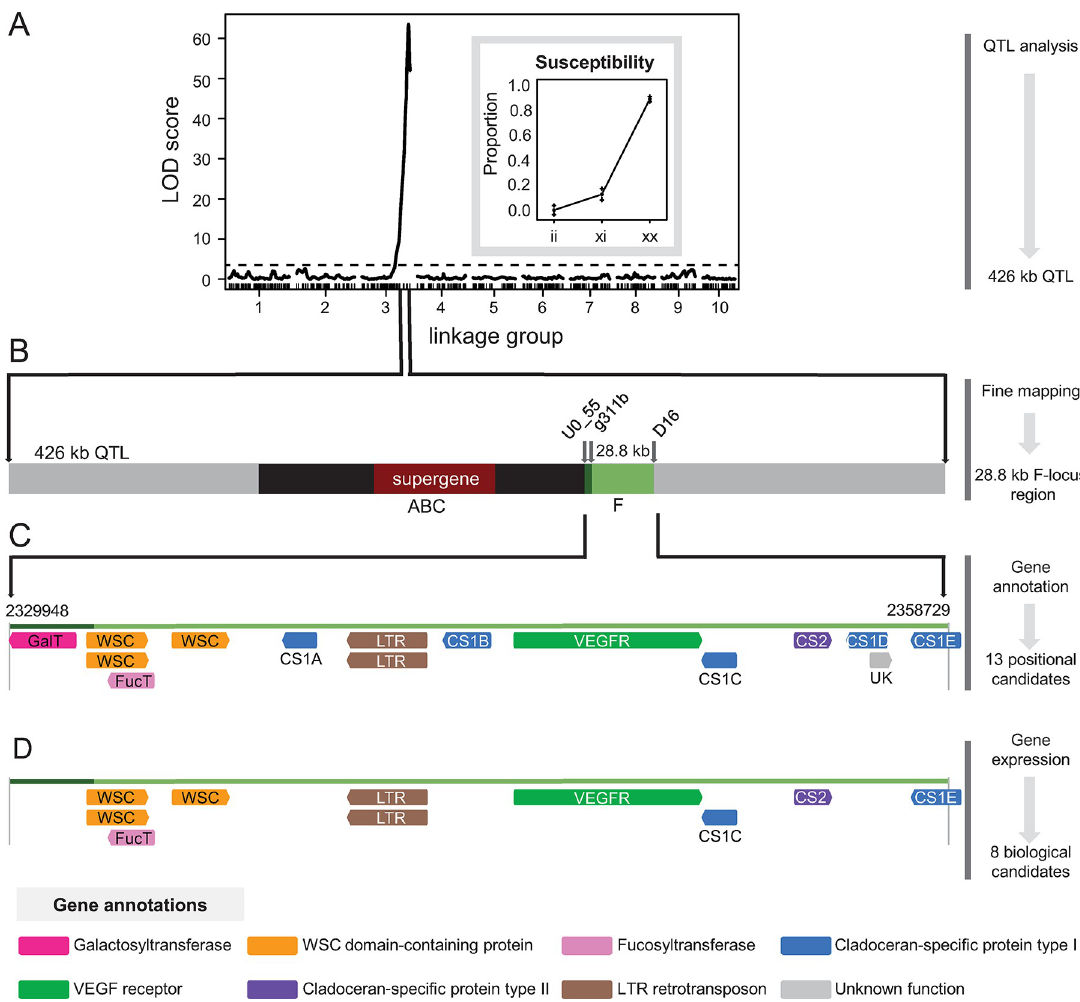
Fig 1. QTL mapping of the polymorphism in Daphnia magna resistance to Pasteuria ramosa genotype P21. Overview of the workflow used in this study to narrow in on candidate genes underlying a resistance polymorphism. Using QTL mapping and recombination breakpoint mapping with additional markers, we associated the polymorphism in resistance phenotype (attachment of Pasteuria ramosa genotype P21 to the hindgut of Daphnia magna hosts) to a 28.8-kb region at the end of linkage group 3 ( Daphnia magna genome version 2.4) which we call the F-locus region. A) Results of the single-QTL genome scan (i.e., interval mapping), showing LOD score (log 10 likelihood ratio) plotted at each SNP marker position in the D . magna genetic map. A strong peak with LOD score 63 explains 57% of the phenotypic variance in resistance to P21. The horizontal dashed line indicates the calculated threshold (LOD = 3.74) used to identify significant ( α = 0.05) QTL. Effect plot (inset) of the SNP marker with the highest LOD score, showing proportion of F2 clones in each genotype group (ii = homozygous for Iinb1 parent clone; xi = heterozygous; xx = homozygous for Xinb3 parent clone) that are susceptible to hindgut attachment by P21. Error bars indicate ± 1 standard error. B) Enlarged schematic view of the 426-kb QTL containing the resistance locus ( D . magna genome version 3.0). The fine-mapped location of the F locus, delimited by SNP markers U0_55 and D16, is shown in green. This F-locus region slightly overlaps with the previously described ABC region (black), which is delimited by SNP marker g311b. The ABC region includes the 50-kb ABC supergene (red), which contains the A, B, and C loci. C) Enlarged schematic of the F-locus region, which lies between positions 2,329,948 and 2,358,729 on contig 000011F and contains 13 putative genes (colored by functional annotation), plus two splice variants, in the reference genome (version 3.0) of clone Xinb3. The region colored in dark green indicates the overlap with the ABC region. D) Sequence comparisons and differential gene expression analysis between the two QTL parent clones identified eight biological candidate genes in the F-locus region. 2,329,948 and 2,358,729 of contig 000011F in the D . magna draft genome version 3.0 (from QTL parent clone Xinb3; BioProject ID: PRJNA624896; Fields et al., in prep.). We call this newly discovered interval the “F-locus region” (i.e., the region containing the F locus), follow- ing from the previously described loci A, B, C, D, and E [16–18]. The F-locus region contains